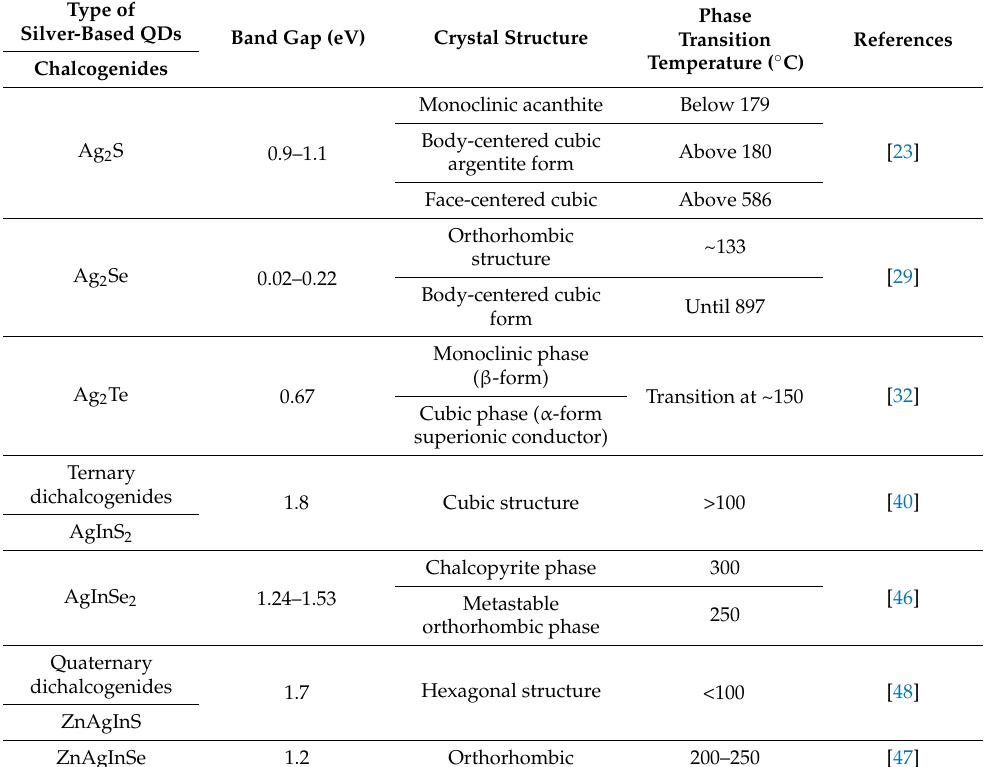
Table 1. Classification of Ag-based